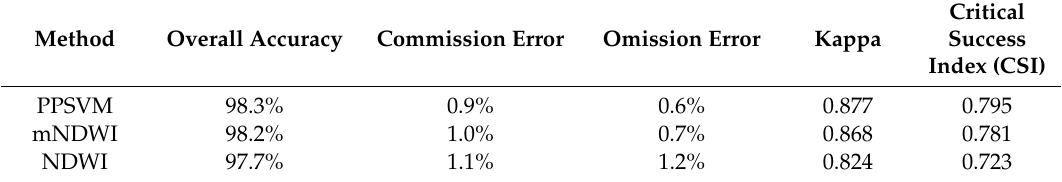
Figure 11. and Table 4 are the resulting maps and accuracy indices for the Shuangtabu reach.